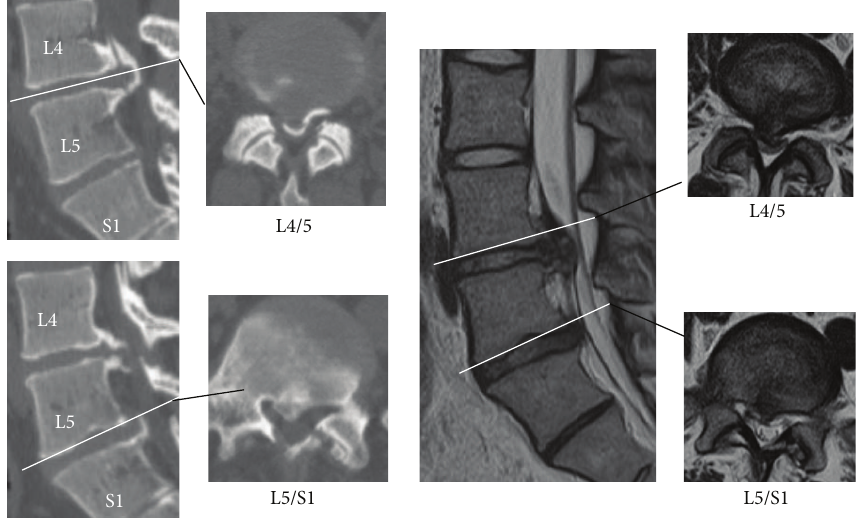
Figure 3: Computed tomography (CT) showed a huge ossification on the dorsal of annulus fibrosus of intervertebral disc at L4/5 at the age of 23 years. Ossification at L4/5 was larger than that at L5/S1. The ossification was consecutive with the posterior end plate at L4/5 and L5/S1. CT did not show an abnormal ossification of annulus fibrosus or posterior longitudinal ligament at the other levels. MRI revealed severe stenosis at L4/5 and the lesion of the posterior endplate lesion still remained at L5/S1.